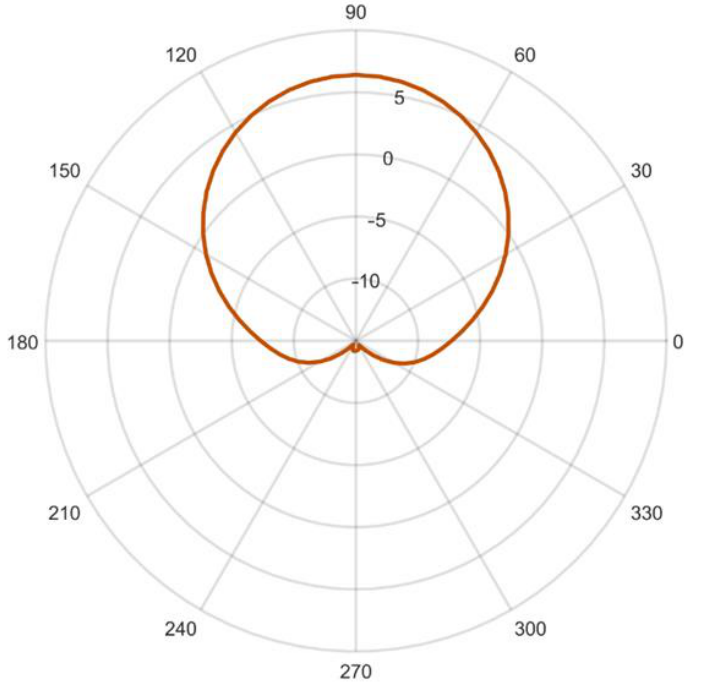
Figure 2. Simulated ESPAR antenna radiation pattern gain (in dBi) at 2.484 GHz for the steering vector V 1 max = [ 111110000000 ] .